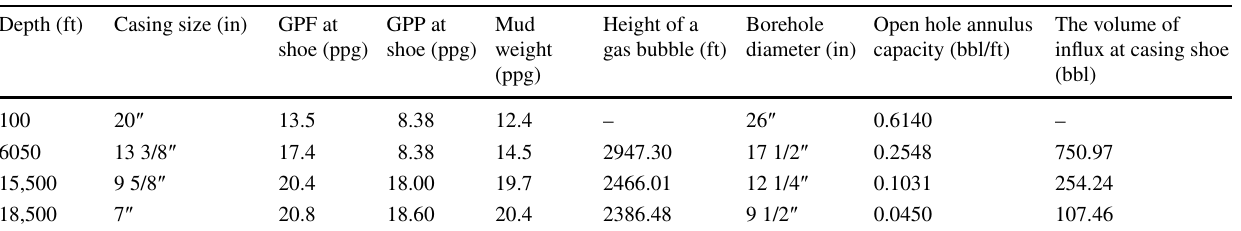
Table 7 Kick tolerance parameter calculation Depth (ft) Casing size